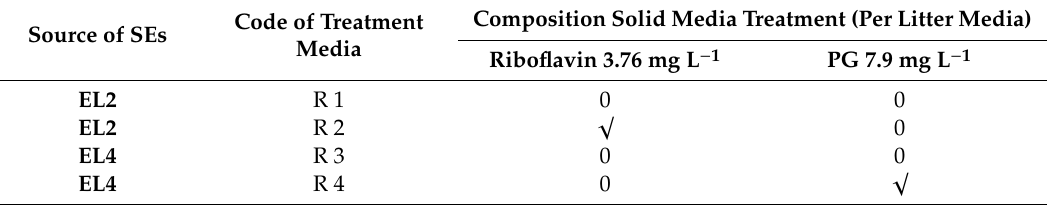
Table 12. The composition of treatment media during the rooting